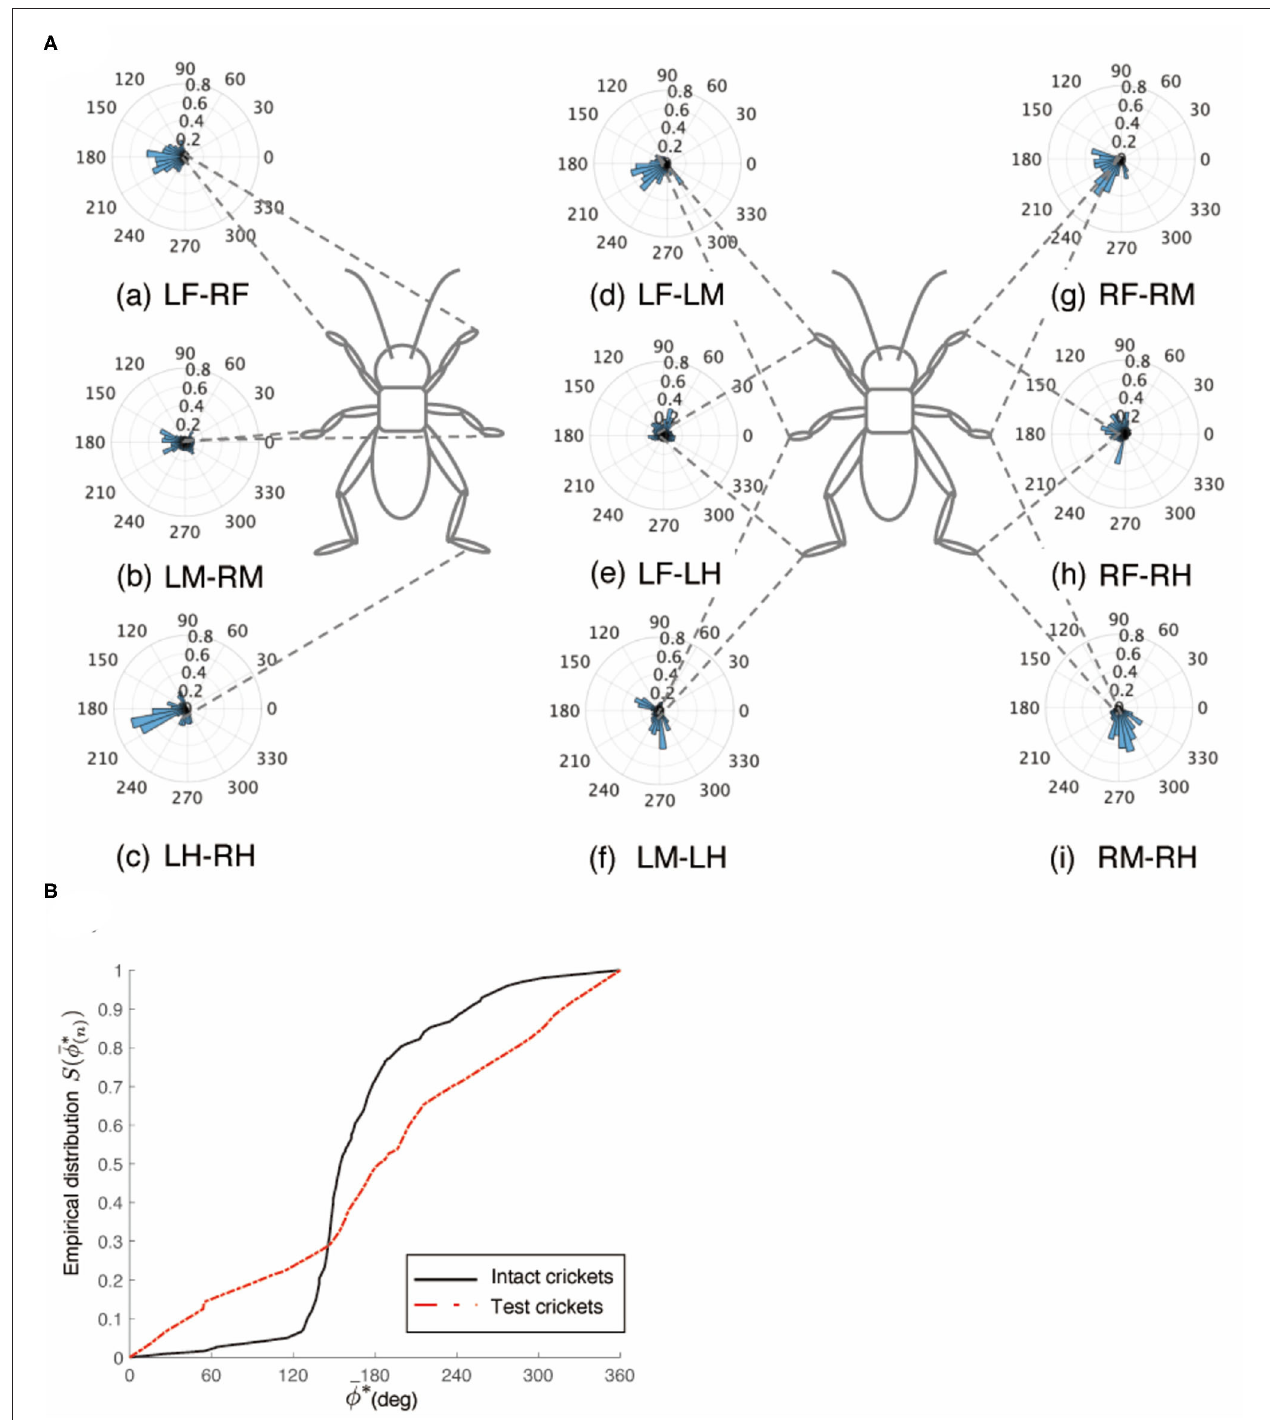
FIGURE 8 | Walking gait patterns of crickets in which paired nerve connectives between metathoracic ganglion and abdominal ganglia were cut. (A) Polar histograms indicate phase differences between two legs in test crickets ( N = 5). The polar histograms demonstrate that the test crickets did not exhibit a tripod gait pattern on the floating ball of the treadmill. (a–i) Phase differences between pairs of legs. (B) Comparison of the empirical distribution function of phase differences between left and right legs Φ LM − RM . The black line indicates the empirical distribution function of the intact crickets and the red line indicates that of the crickets in which the paired nerve connectives between the metathoracic ganglion and abdominal ganglia were cut. LF, left foreleg; RF, right foreleg; LM, left midleg; RM, right midleg; LH, left hind leg; RH, right hind